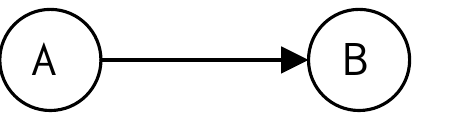
Figure 6. A simple Bayesian network consisting of events A and B.